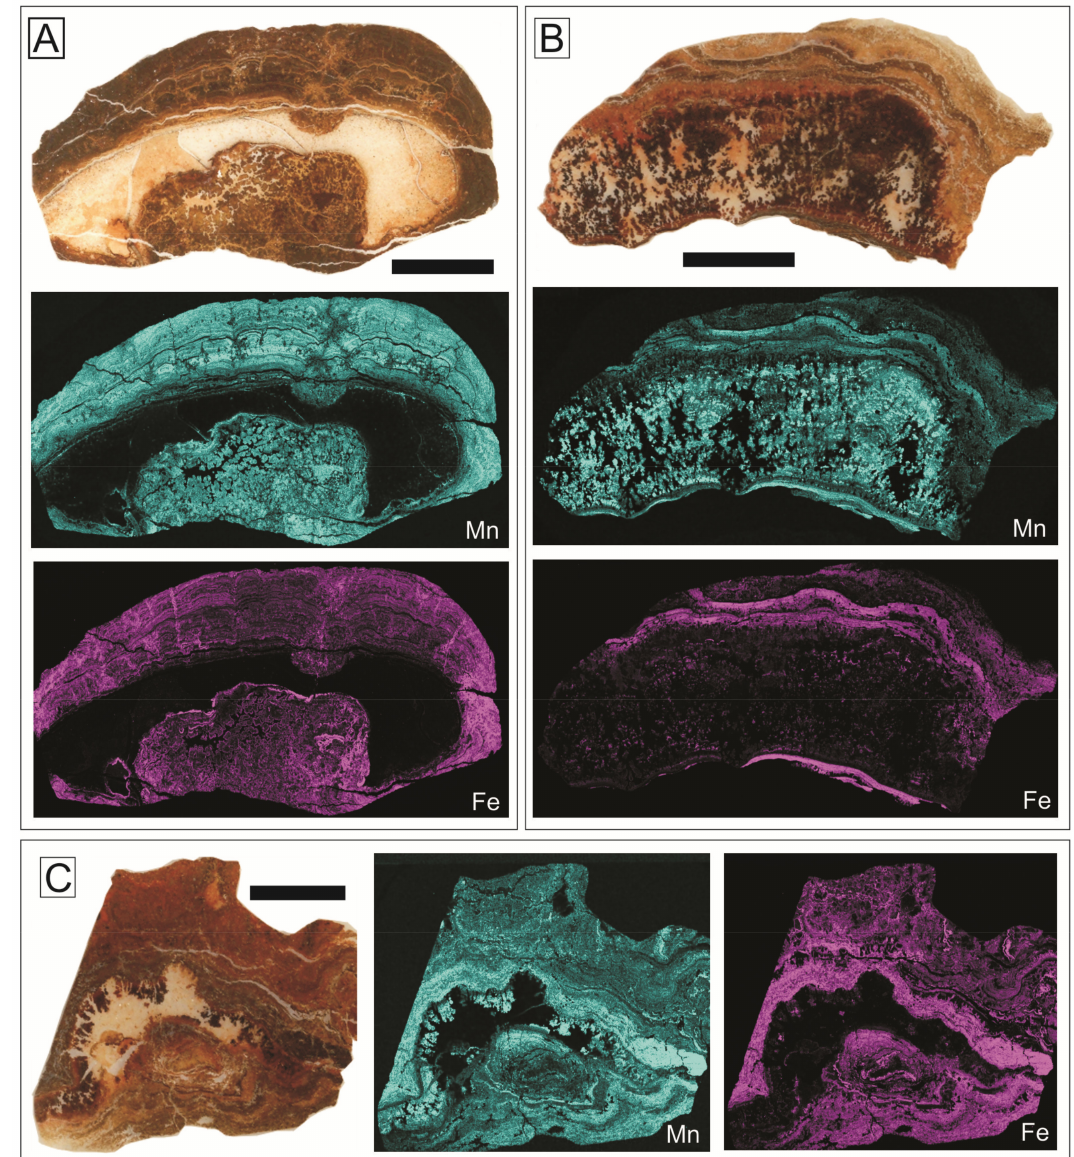
Figure 8. Elemental maps of XR-microfluorescence for Mn and Fe. ( A ) Part of an iron macro-oncoid developed on an ammonoid fragment from Qu í par outcrop (Eastern External Subbetic, Callovian- Oxfordian hardground). ( B , C ) Fragments of Fe crust from L ú gar outcrop (Bathonian hardground) with planar and arborescent laminated fabrics. Note that Mn-rich areas correspond to arborescent darker parts. Scale bars = 1